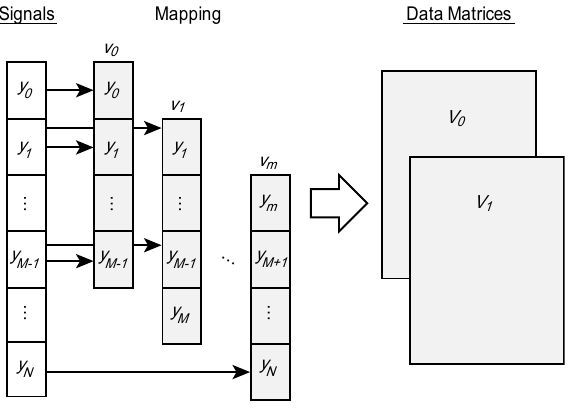
Figure 5. A method of creating a matrix for DMD from the CP